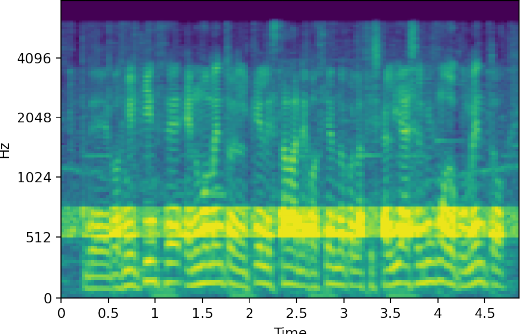
Figure 6. Spectrogram modified to alter the network prediction from “Happy” to “Calm”, intensifying frequencies above 512 Hz.